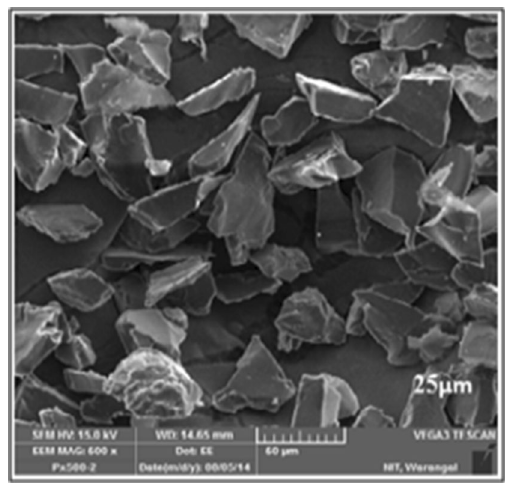
Fig.2 SEM image of boron carbide (B